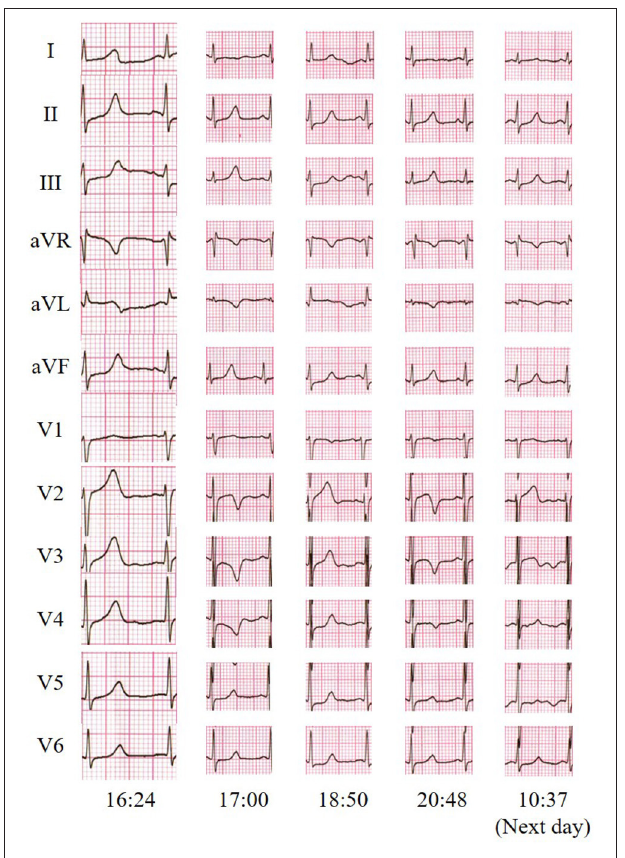
FIGURE 1 | Twelve-lead electrocardiogram indicated transitional T-wave inversion in the leads I, aVL, and V2 through V4 and shortly returned to normal.